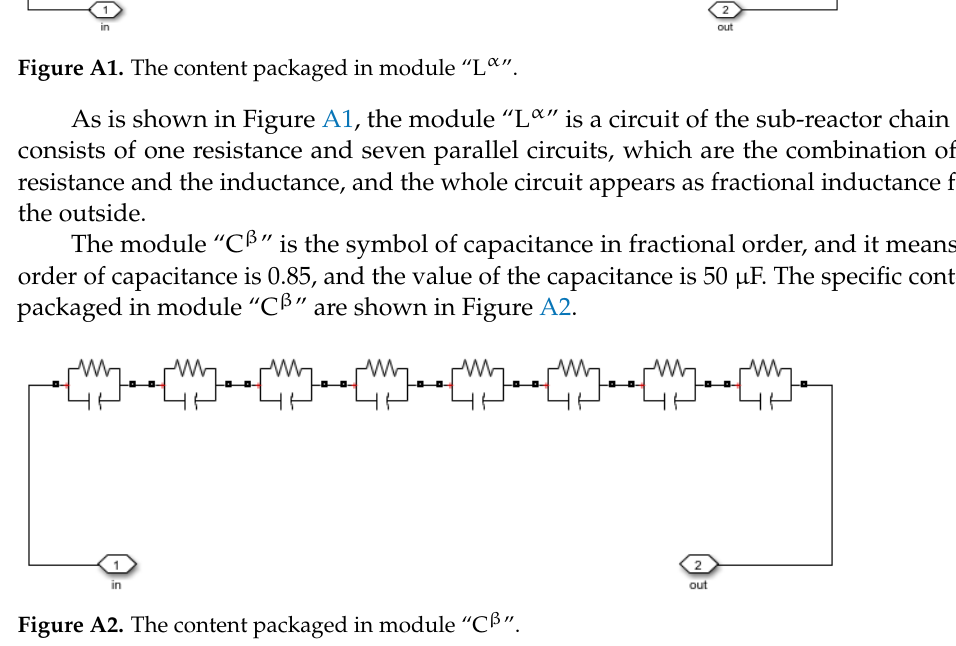
Figure A2. The content packaged in module “ C β ”.